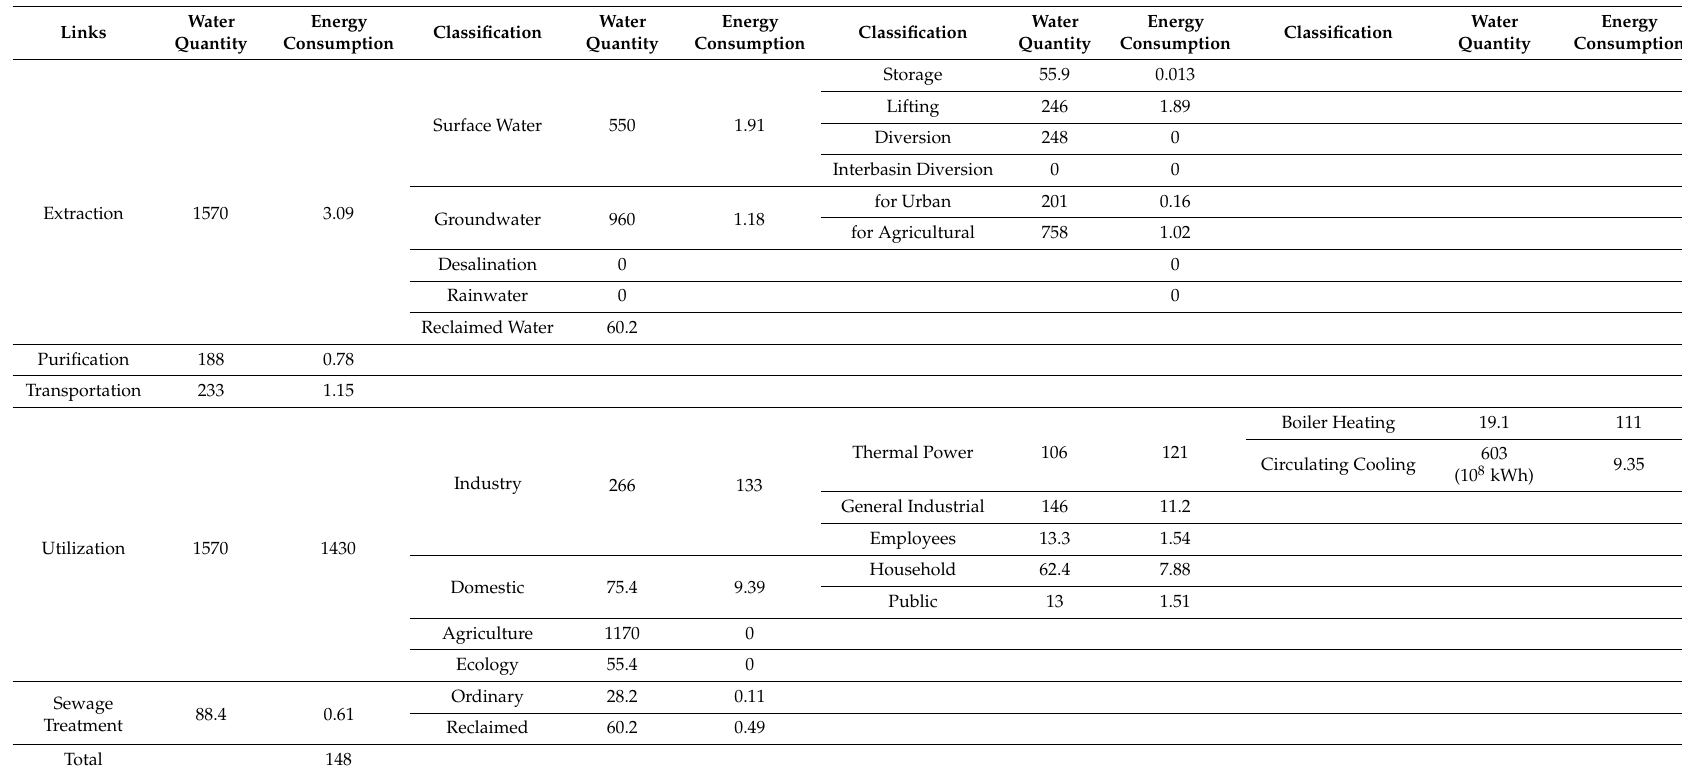
Table A2. Energy consumed through the use of water in Ordos, China, for